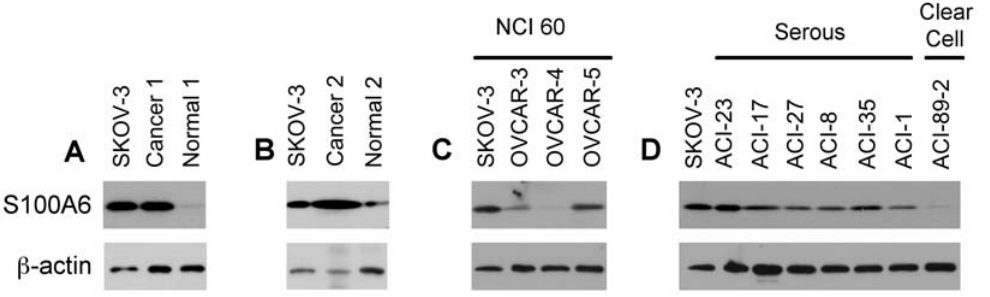
Figure 5. S100A6 expression in human OVCA cell lines and tissues by Western blot analysis. (A and B) Paired lysates of OVCA (cancer) and adjacent normal ovary tissue (normal) from 2 OVCA patients were blotted for S100A6 expression. SKOV-3 cell lysate was used for comparison. (C and D) S100A6 expression in OVCA cell lines from NCI60 (SKOV-3, OVCAR-3, 4 and 5) as well as cell lines derived from OVCA patients (see also Materials and Methods).